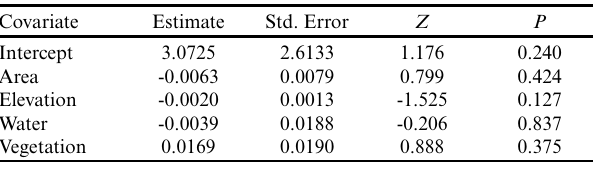
Table 2 . Regression model testing the relationship between treatment type and habitat characteristics within study